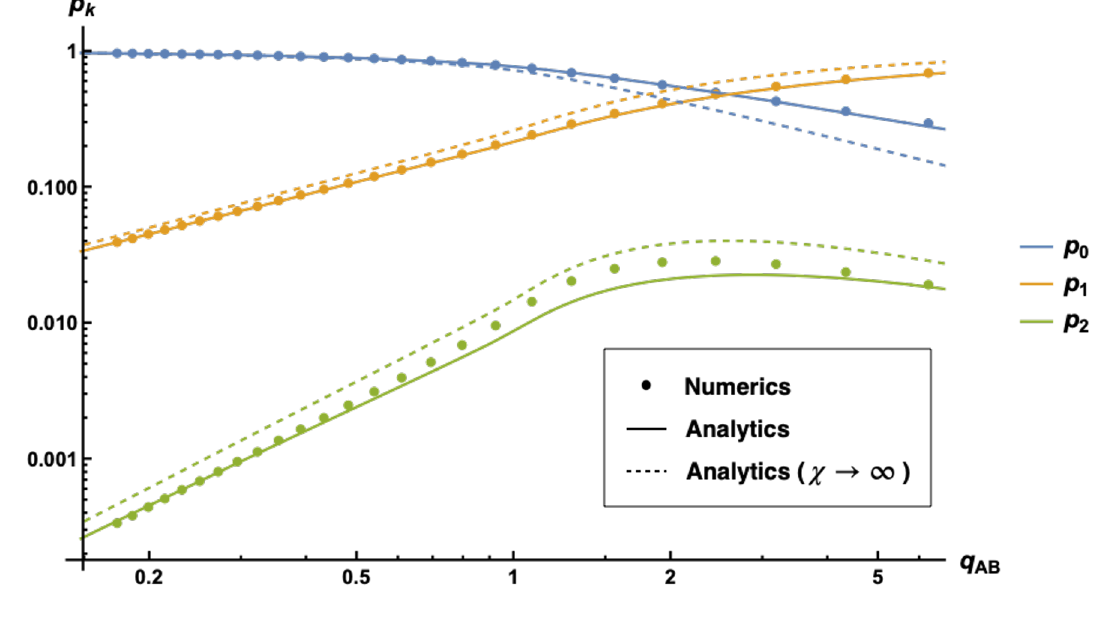
Figure 19 . Plots of the sector probability p k . The analytic result (solid lines) is obtained from the product of sector multiplicity d and eigenvalues λ . The d used here are the exact expressions k k k in eq. (4.14) and the λ used here includes the first order shifts. We also incorporated the exact k expression of p at χ → ∞ (eq. (4.50)) as dashed k